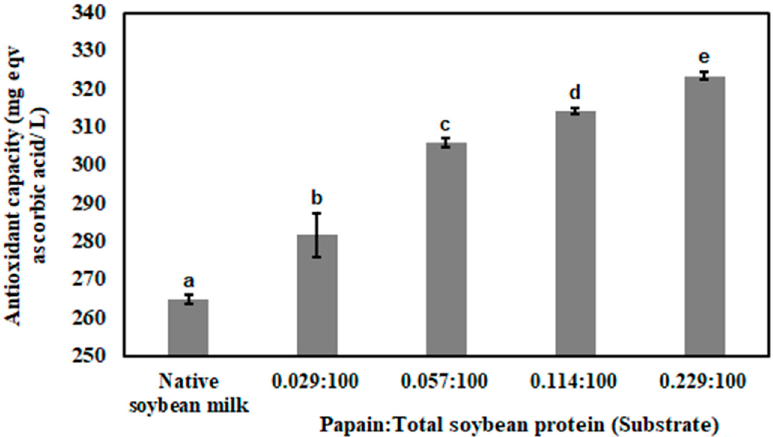
Figure 5. Antioxidant capacity of native soybean milk and papain-treated soybean milks, prepared with different concentrations of papain at temperature 50 °C.